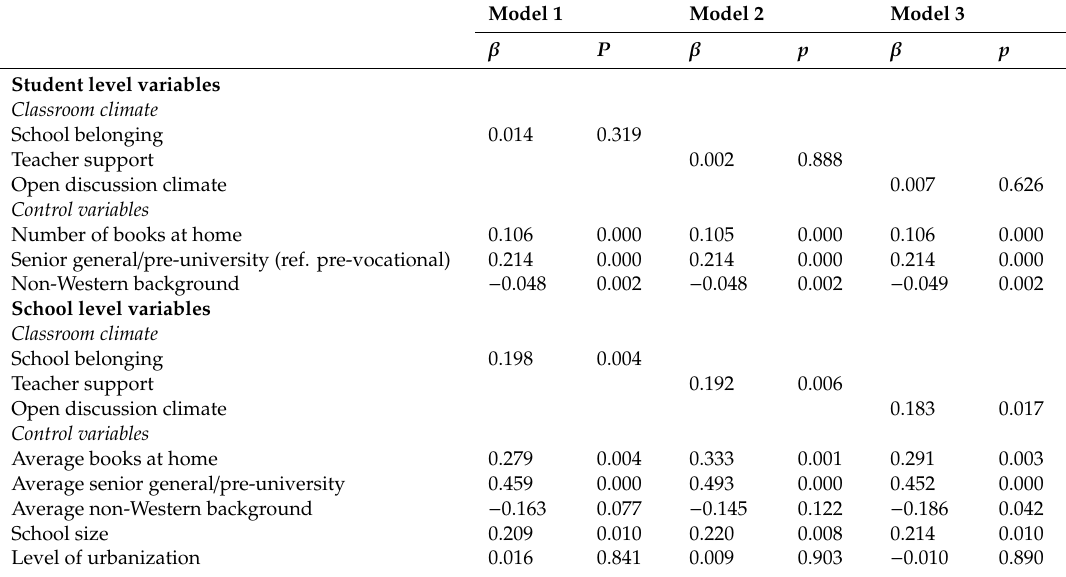
Table A6. Classroom climate e ff ects on citizenship knowledge (standardized betas).